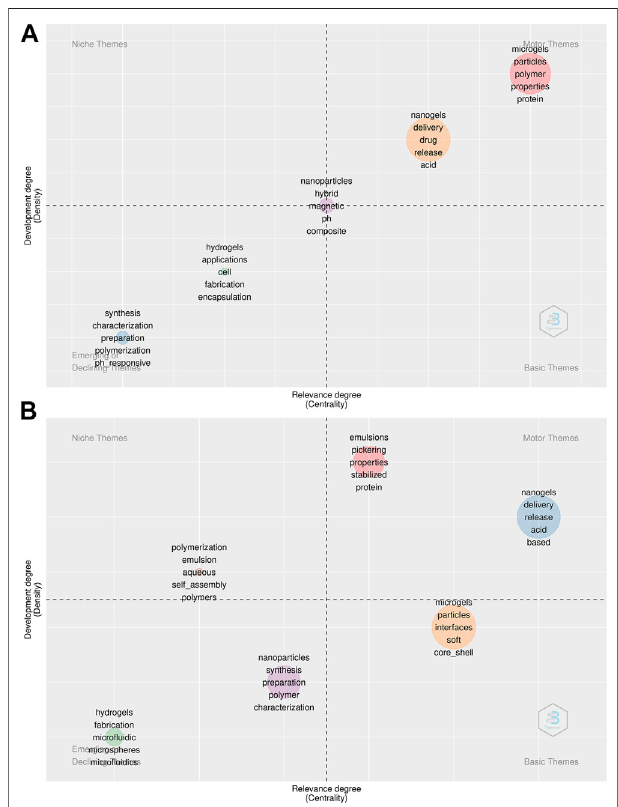
FIGURE 4 | Conceptual structure of the topic. Thematic map. Thematic map constructed from the 1,000 most relevant words present in titles between the years 2010 – 2020 for (A) the main topic “ microgels and nanogels ” and (B) the sub-topic “ microgels and nanogels at interfaces and emulsions ” . The themes, clusters of words co-occurrences, are plotted with respect to a x -axis (centrality), and a y -axis (density). The fi ve more relevant terms in each theme are represented and the size corresponds to the total occurrences of the words belonging to a theme. Plots are produced with